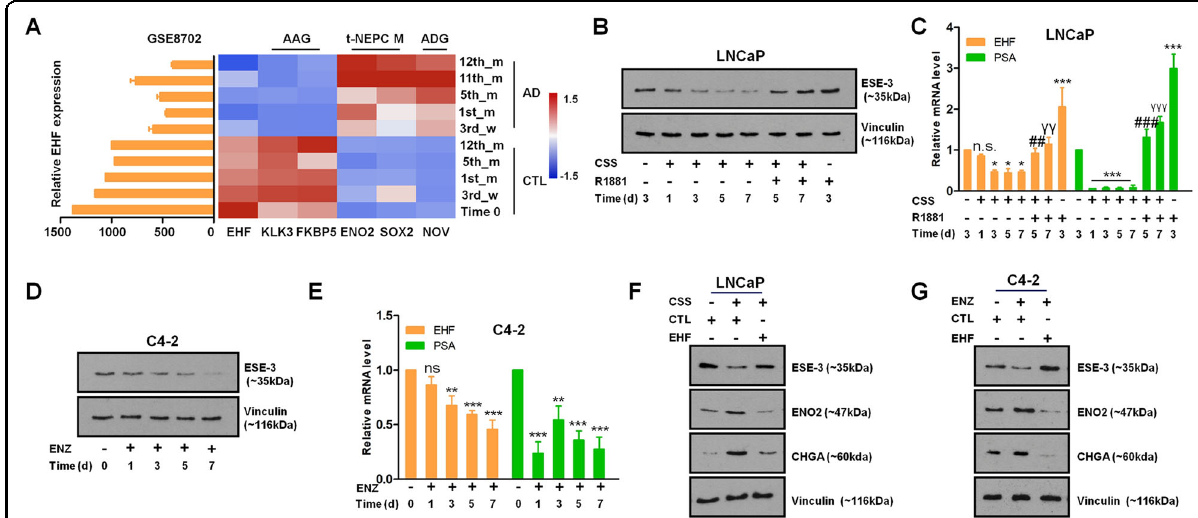
Fig. 2 ADT-induced EHF depression is important for NE differentiation. A Bar graph showing EHF expression (left) and heatmap of AR- associated genes including EHF, t-NEPC markers, and an androgen-depressed gene in long-term androgen-deprived LNCaP cells (GSE8702). B , C Effects of androgen deprivation (by culturing in CSS medium) and AR ligand R1881 on EHF expression in LNCaP cells were measured by qPCR and immunoblotting. P values for each sample were obtained based on nontreated controls (*) and cells cultured in CSS medium for 5 days ( # ) or for 7 days ( γ ) for EHF and PSA, respectively. D , E Effects of ENZ on EHF expression in C4-2 cells were determined by qPCR and immunoblotting. P values for each sample were obtained based on nontreated controls (*) for EHF and PSA. F EHF, ENO2, and CHGA protein levels in LNCaP cells with/without EHF overexpression responsive to androgen deprivation (by culturing in CSS medium for 48 h) were measured by immunoblotting. G EHF, ENO2, and CHGA protein levels in C4-2 cells with/without EHF overexpression responsive to ENZ treatment for 48 h were measured by immunoblotting. All qPCR and immunoblotting assays were repeated in triplicate. The two-tailed Student ’ s t test or one-way ANOVA, followed by Dunnett ’ s t test was used to compare results between two groups with * denoting p < 0.05, **/##/ γγ denoting p < 0.01, and ***/###/ γγγ denoting p < 0.001. Bar graphs show means ± SD. AAG AR-associated genes, M markers, ADG androgen-depressed gene, AD androgen deprivation, CTL control, CSS charcoal-stripped serum, ENZ enzalutamide, n.s. not signi fi